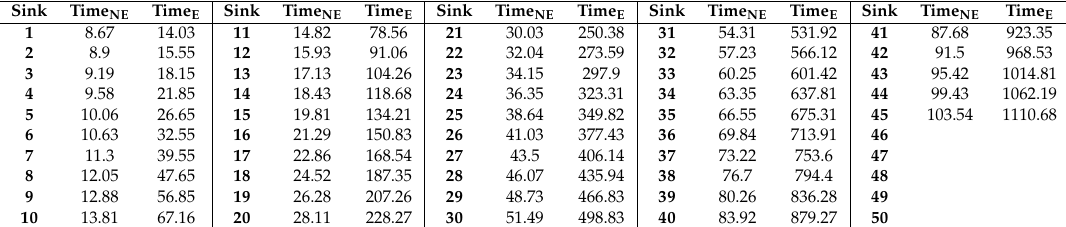
Table 8. Scenario 5: transmission times (in s) for each sink all over the transmission line. (Distance between poles is equal to 100 m, κ = 1, η = 45, NE means no encryption, E means